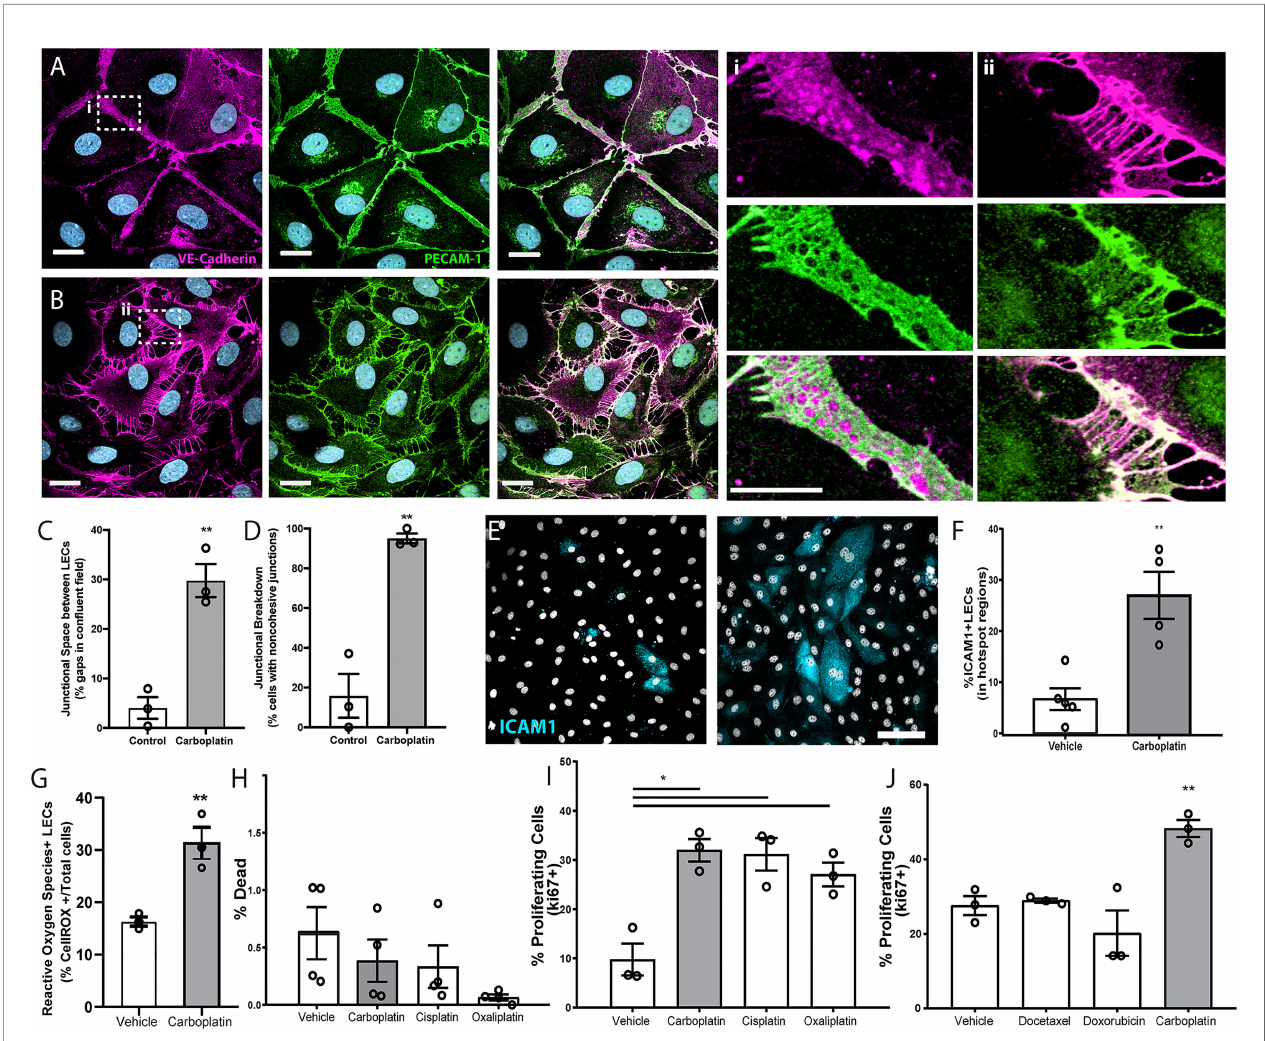
FIGURE 1 | Lymphatic endothelial cell (LEC) monolayers are activated by carboplatin. (A) Vehicle-treated human LECs in monolayer culture; VE-cadherin (magenta) and PECAM-1 (green) with DAPI (gray-blue) for nuclei (scale bar=25µm) with (i) high magni fi cation image cell-cell junction. (B) Human LEC monolayer treated with 1µM carboplatin with (ii) high magni fi cation image of cell-cell junction. (C) Size of gaps between cells within a single fi eld of view; listed as percentage of the fi eld that is comprised of intracellular gap space (n=3/group). (D) Percentage of cells within fi elds of view that display non-cohesive junctions (n=3/group). (E) Representative images of LECs nuclei (DAPI, gray) and ICAM1 (cyan). Scale bar=250µm. (F) Percent ICAM1+ LECs in hotspot regions (n=5/group). (G) Percent ROS+ LECs per fi eld (n=3/ group). (H) Percent dead cells per fi eld after 48h of platinum agent (1µM) assessed by amine-based fl uorescent reactive dye (n=4/group). (I) Percent proliferating cells per fi eld by KI67 positivity after 6h in culture with platinum agents (1 µM) (n=3/group). (J) Percent proliferating cells per fi eld by Ki67 positivity after 6h in culture with chemotherapeutic agents (1 µM) (n=3/group). Each data point/n represents one independent experiment (i.e. biological replicate). *p < 0.05, **p <